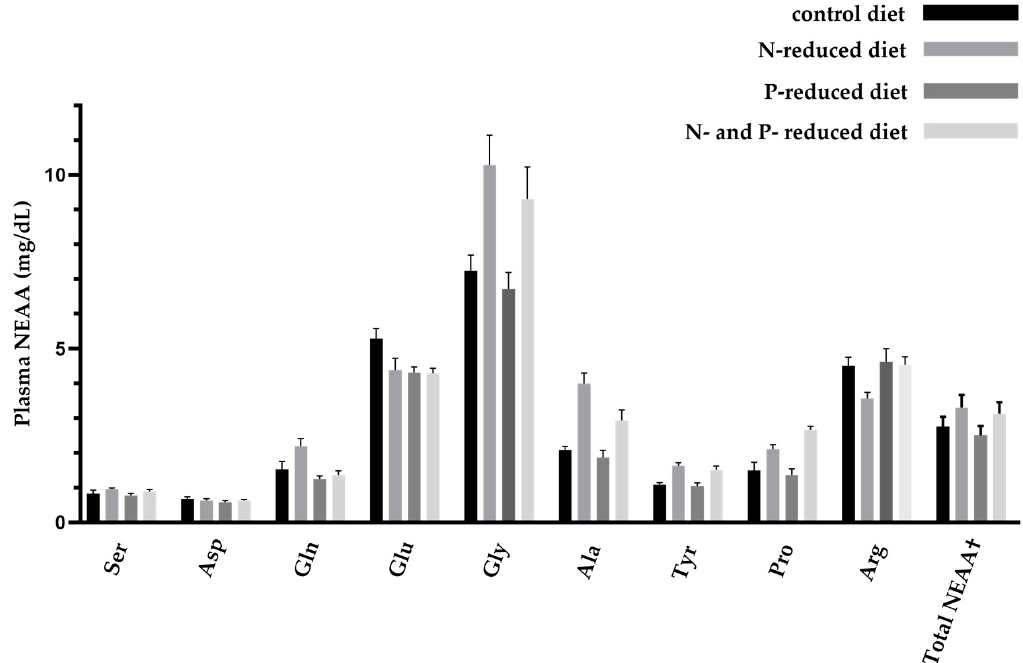
Figure 2. Overview of circulating non-essential amino acids (NEAA) in young goats fed an N- and/or P-reduced diet. Mean values with their standard error. Mean values that differ significantly in the Tukey test are shown in Table 5 with different superscript letters. n = 7 animals. † n = 63 animals.